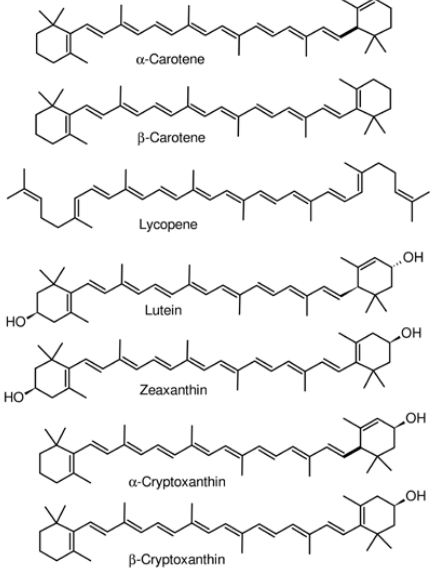
Figure 2. Chemical structures of carotenoids detected in human milk. Table 1. Concentrations of phytochemicals found in human milk.